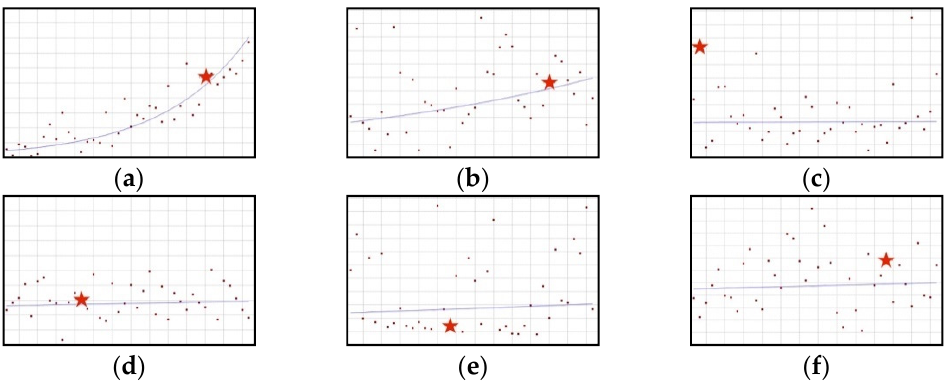
Figure 1. A schematic graph of the frequency of use of ingredients in the respective quarters in the period from the first quarter of 2012 to the fourth quarter of 2021. The star denotes the moment of publication of a scientific opinion or a resolution concerning the ingredient. The height of placement of the symbol reflects the level of use of the ingredient. ( a ): Ashwagandha (Figure A1); ( b ): Astaxanthin (Figure A2); ( c ): Lactoferrin (Figure A3); ( d ): Lycopene (Figure A4); ( e ): Trans-resveratrol (Figure A5); ( f ): White mulberry (Figure A6).